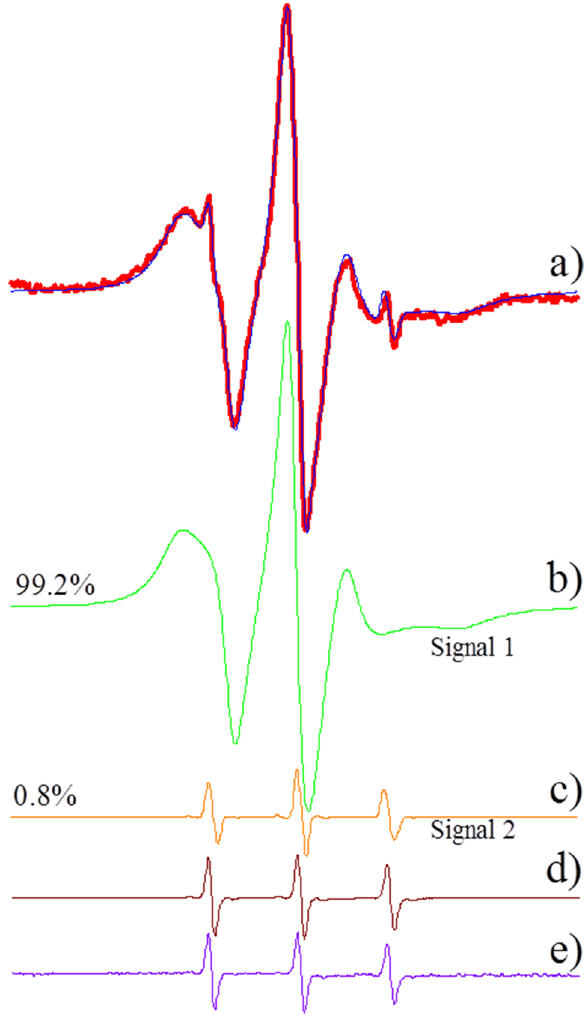
Figure 6. ESR experimental spectrum of the 16-PCSL incorporated in gel membrane of DPPG (5 mM) in the presence of 0.1 mol% CTX ( a , red line), the same spectrum shown in Fig. 5 h. The blue line corresponds to the best fitting of the theoretical simulation on the experimental data considering two components: the anisotropic site ( b , Signal 1, green line) and a highly isotropic site ( c , Signal 2, orange line). The proportion of the two components are indicated. The theoretical mobile component is very similar to the experimental spectrum obtained for 16-PCSL in solution in presence of the Crotoxin ( d , wine line) and that of the pure probe 16-SASL in buffer PBS ( e , violet line). The total spectra width is